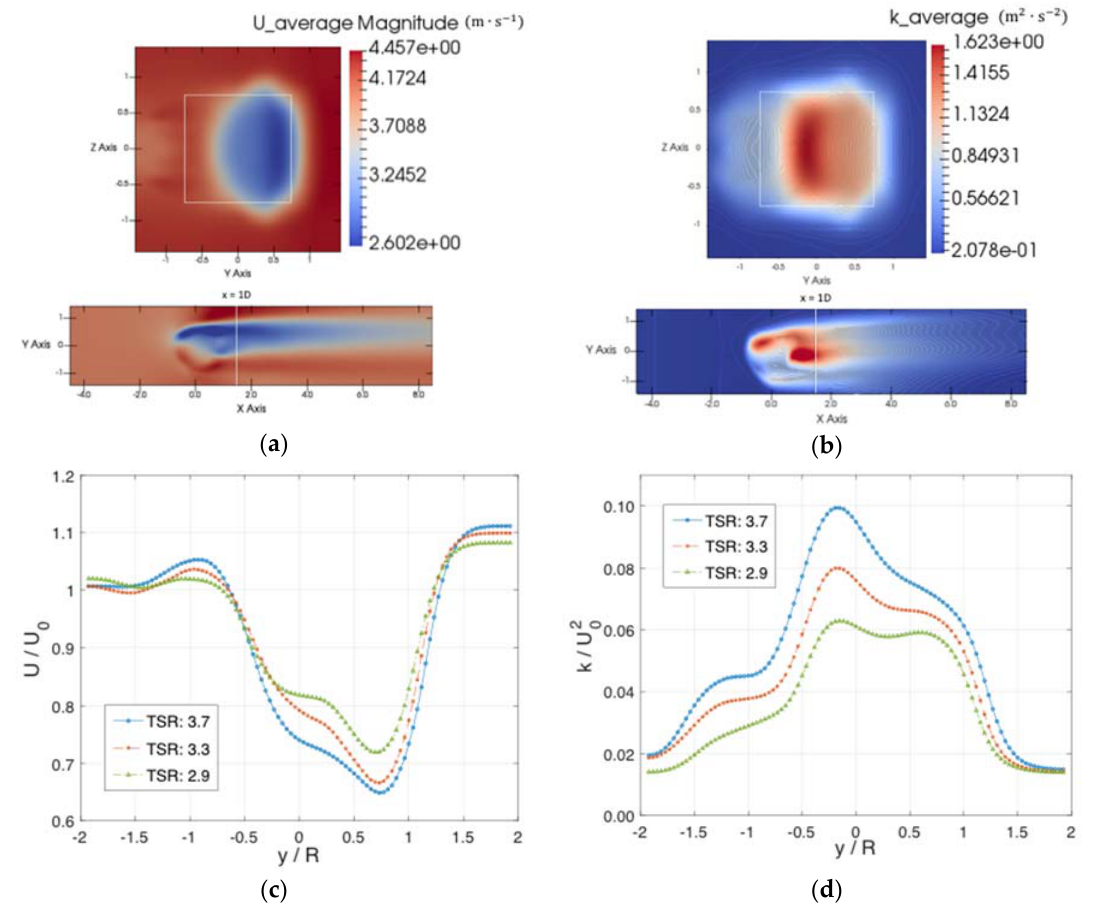
Figure 12. Near wake flow at x / D = 1 and z / H = 0: ( a ) Slices through the mean velocity field in the y - z and x - y planes at TSR = 3.7; ( b ) Slices through the mean turbulence kinetic energy contours at TSR = 3.7; ( c ) Mean stream-wise velocity profiles for TSR = 2.9, 3.3, and 3.7; and ( d ) Mean turbulence kinetic energy profiles for TSR = 2.9, 3.3, and 3.7 .